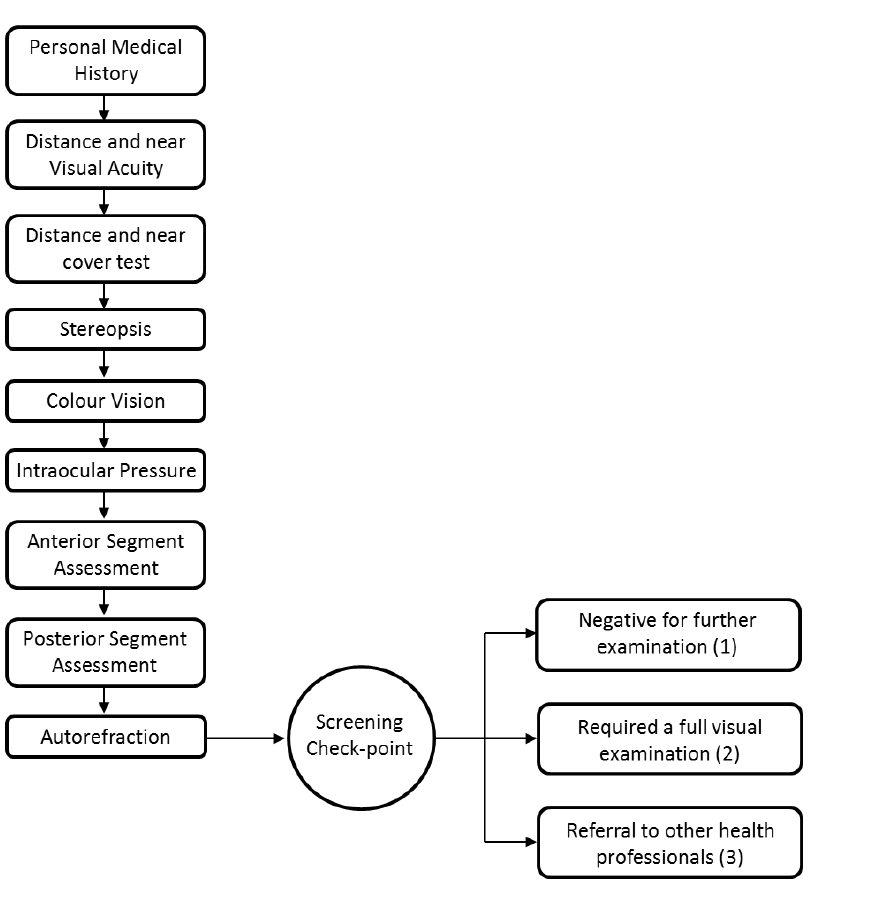
Figure 1. Special Olympics Lions Club International Opening Eyes (SOLCIOE) vision screenings